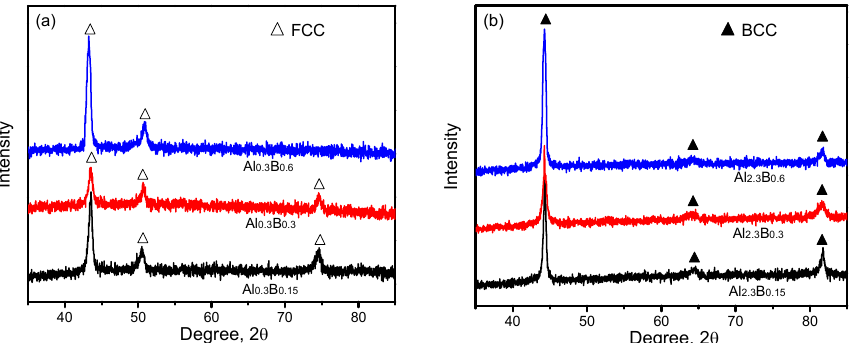
Figure 1. XRD patterns of the CoCrFeNiAl x Cu 0.7 Si 0.1 B y high entropy alloy (HEA) coatings: ( a ) Al 0.3 B y component series; ( b ) Al 2.3 B y component series. BCC: body-centered cubic; FCC: face-centered cubic.